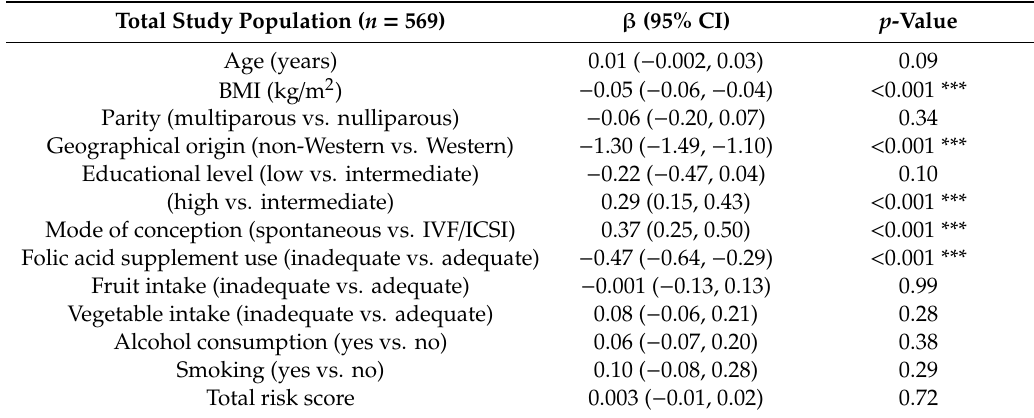
Table 2. Univariate associations between maternal baseline characteristics, nutrition and lifestyle behaviours and the neighbourhood status score (NSS) for the total study population. Total Study Population ( n = 569) β (95% CI) p -Value Age (years) 0.01 ( − 0.002, 0.03) 0.09 BMI (kg / m 2 ) − 0.05 ( − 0.06, − 0.04) < 0.001 *** Parity (multiparous vs. nulliparous) − 0.06 ( − 0.20, 0.07) 0.34 Geographical origin (non-Western vs. Western) − 1.30 ( − 1.49, − 1.10) < 0.001 *** Educational level (low vs. intermediate) − 0.22 ( − 0.47, 0.04) 0.10 (high vs. intermediate) 0.29 (0.15, 0.43) < 0.001 *** Mode of conception (spontaneous vs. IVF / ICSI) 0.37 (0.25, 0.50) < 0.001 *** − 0.47 ( − 0.64, − 0.29) < 0.001 *** Fruit intake (inadequate vs. adequate) − 0.001 ( − 0.13, 0.13) 0.99 Vegetable intake (inadequate vs. adequate) 0.08 ( − 0.06, 0.21) 0.28 Alcohol consumption (yes vs. no) 0.06 ( − 0.07, 0.20) Smoking (yes vs. no) 0.10 ( − 0.08, 0.28) 0.003 ( − 0.01, 0.02) 0.72